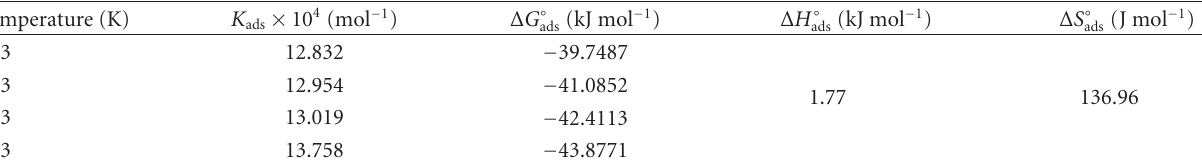
Table 5: Values of thermodynamic parameters for the adsorption of the inhibitor in 1 M HCl on the mild steel at di ff erent temperatures.